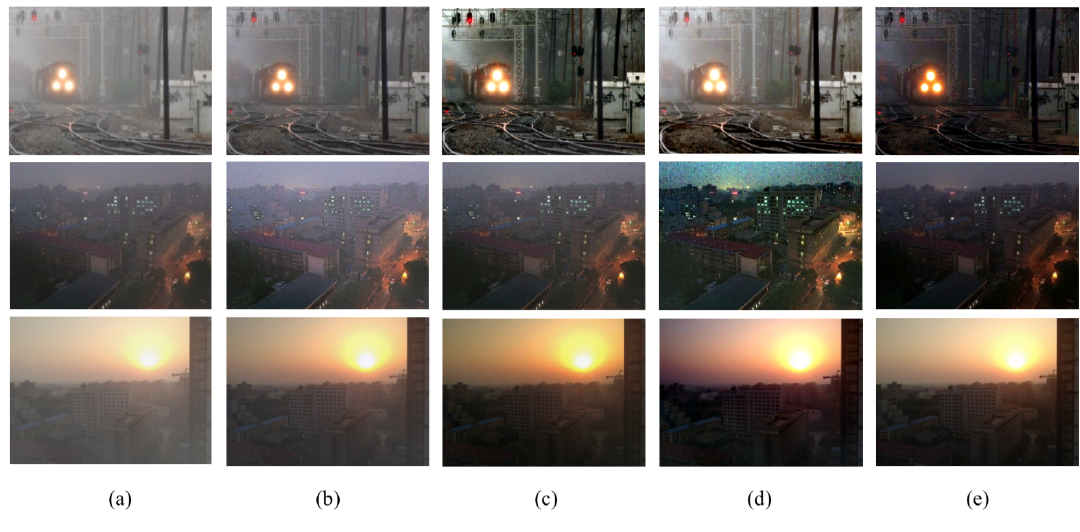
Figure 16. Visual comparison on nighttime hazy images: ( a ) hazy image; ( b ) He’s method [14]; ( c